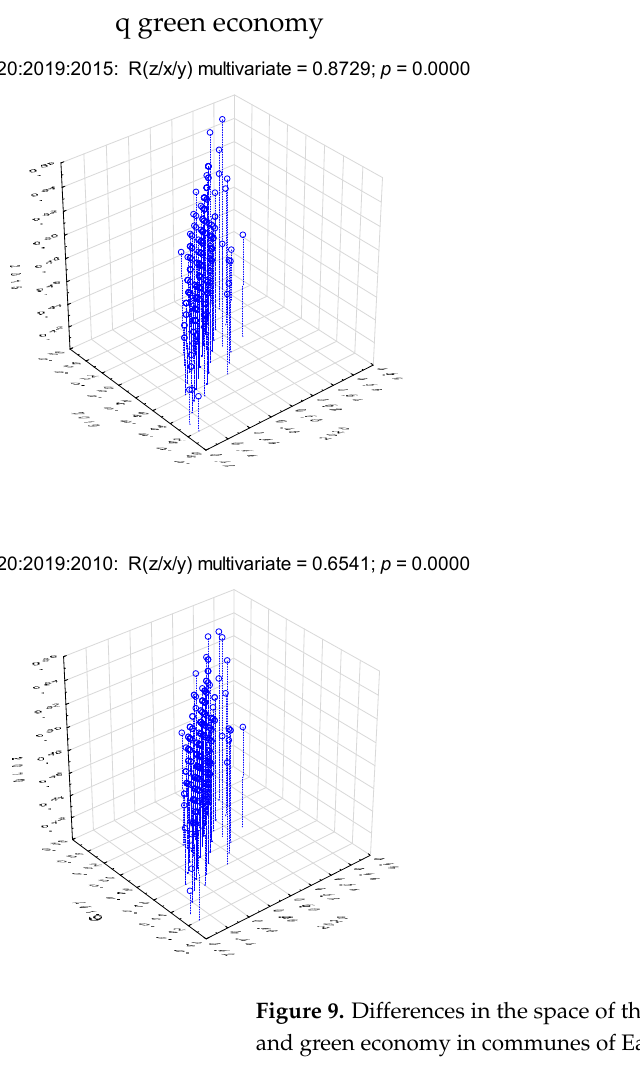
Table 3. Coefficients of correlation between the value of waste management (zero west) and ecology and natural environment of poviats and their values in 2020.